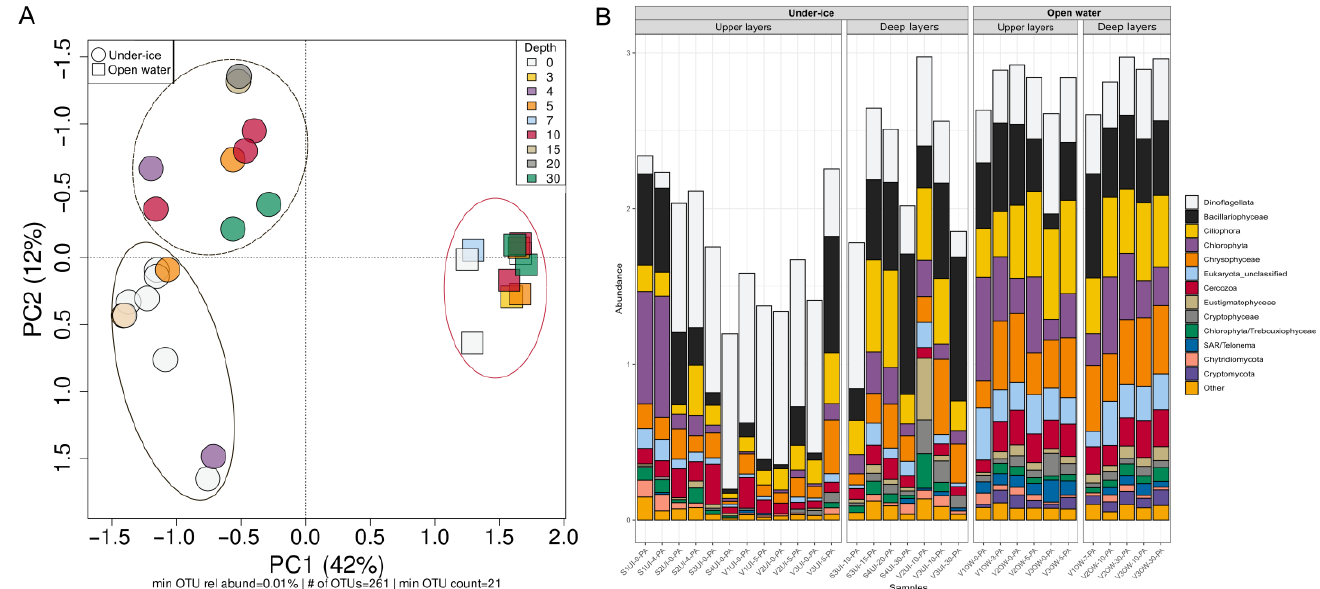
Figure 4. Microeukaryotic community composition of PA samples. PCoA of microeukaryotic com- munities. Glyph shape denotes under-ice (circle) and open-water (square) periods of community sampling. Glyphs are colored according to the depth at the sampling point. The under-ice samples of the upper layers circles are colored by the black oval, the under-ice samples of the deep layers are colored by the black dotted oval, and the summer samples circles are colored by the red oval ( A ). Hellinger-transformed relative abundances of the top-13 microeukaryotic phylotypes in PA com- munities. The bar stacks are arranged into four facets by two factor variables: “Layers“ and “Period”. The profiles are horizontally sorted by sampling site, month and sampling layer. Taxa presented in the color legend are sorted by total abundance in the decreasing order, except the last category, “Other”. The order of phylotypes in each bar is the same as in the color legend ( B ).